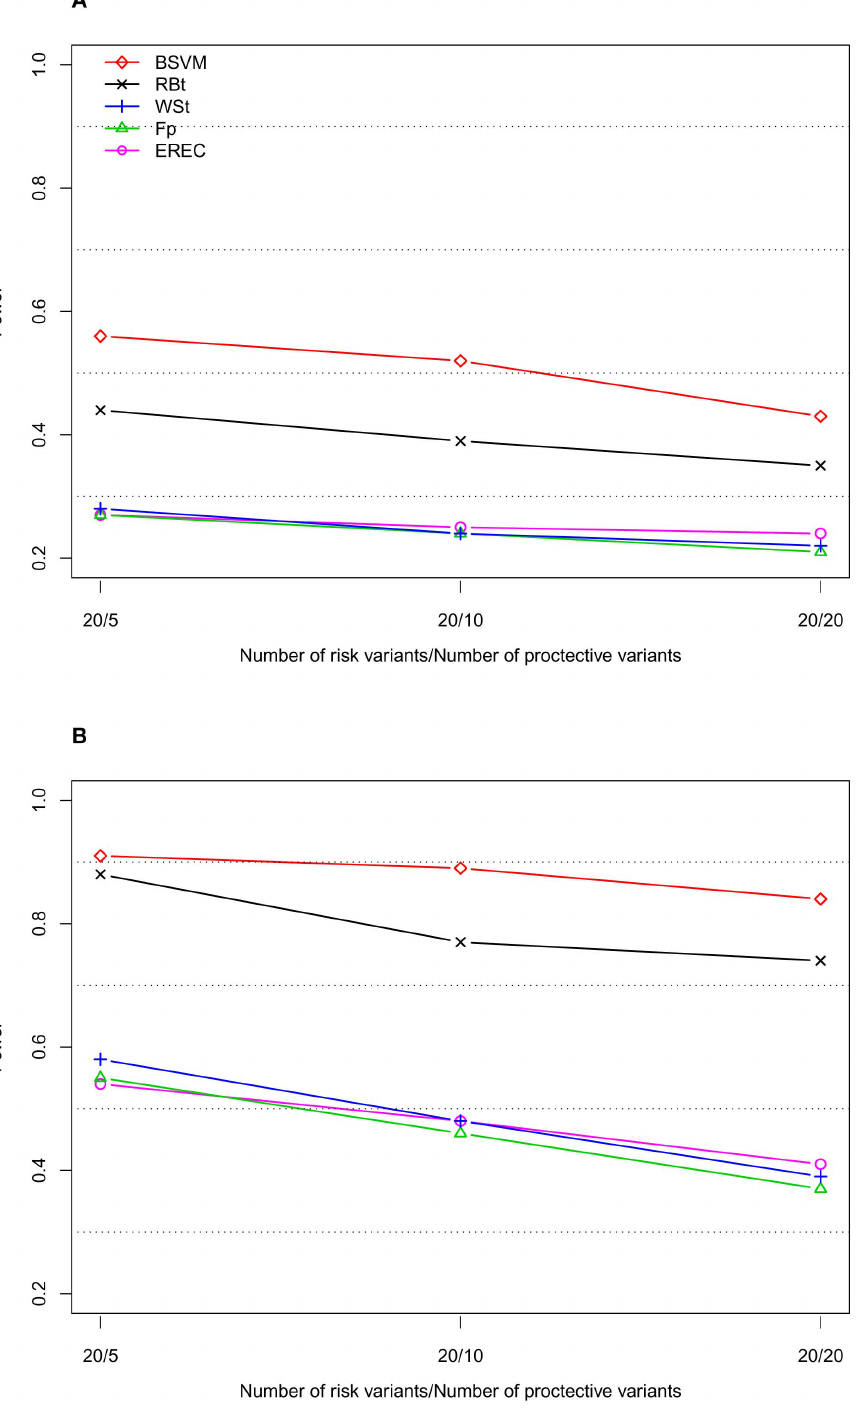
Figure 3. Power of the five approaches with equal PARs in the presence of a mixture of risk, neutral, and protective variants. The sample size is 1000. The nominal level is 0.05. A. PAR=0.03; B. PAR=0.05.